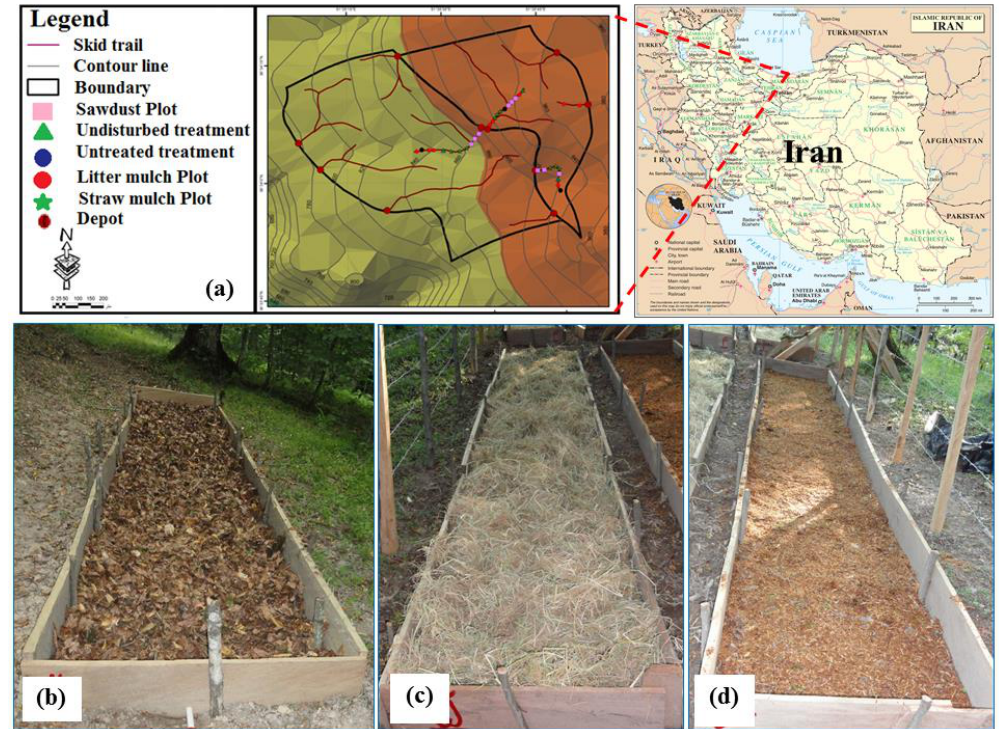
Figure 1. The study area in Namkhaneh District in the Hyrcanian forests ( a ), skid trail with litter mulch level of 12.2 Mg ha − 1 (LM12.2, b ), skid trail with straw mulch level of 11.4 Mg ha − 1 (SM11.4, c ); skid trail with sawdust mulch level of 22.2 Mg ha − 1 (SDM22.2, d ).